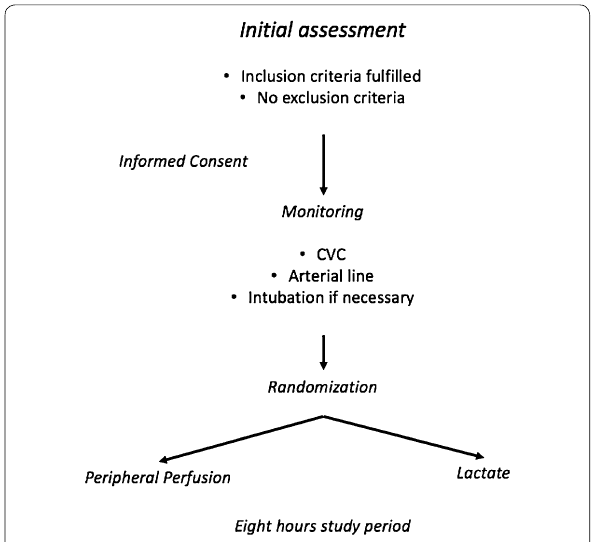
Fig. 1 Pre‑randomization phase assessments and interventions. CVC central venous